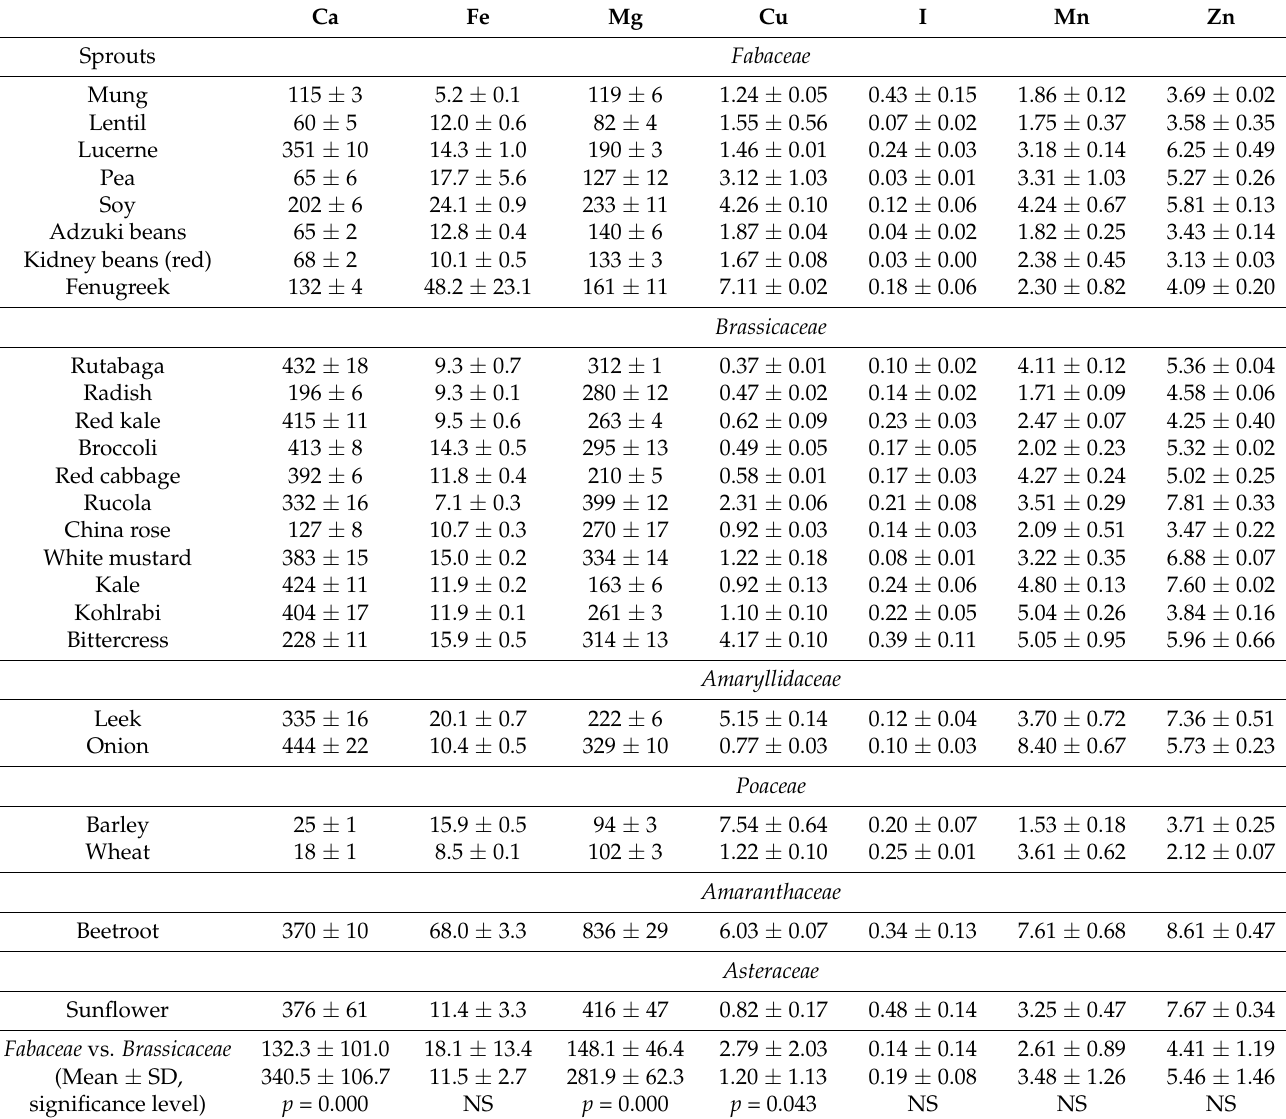
Table 1. Concentrations of essential minerals and trace elements in sprouts from different